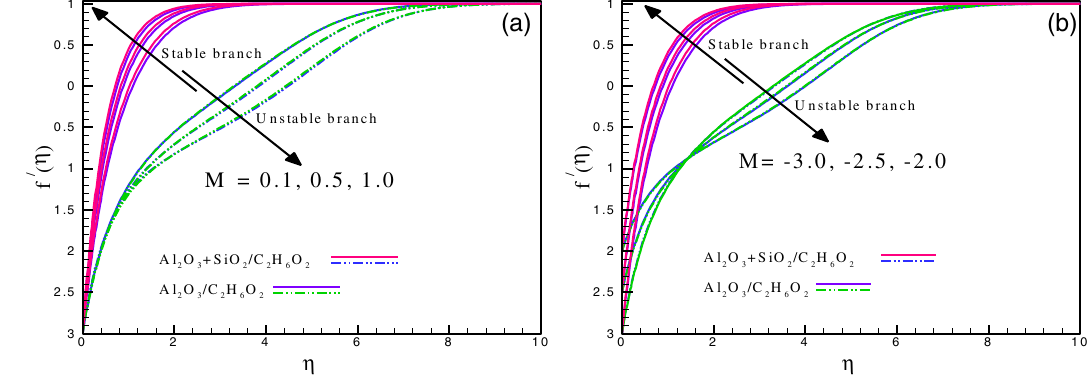
1 2 Nu for different values of R d .